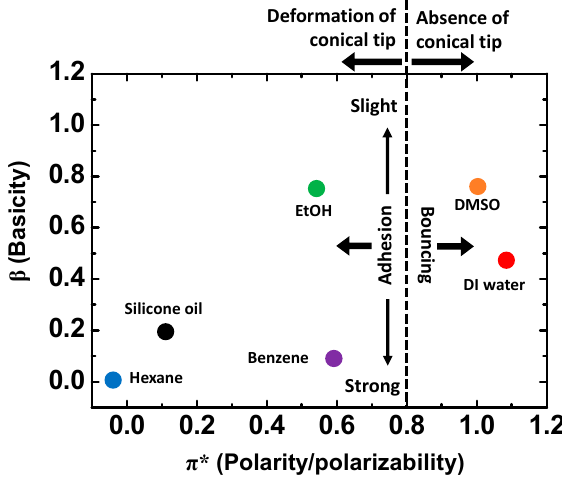
Figure 5. Interfacial behaviors depending on Kamlet–Taft parameters β and π * .